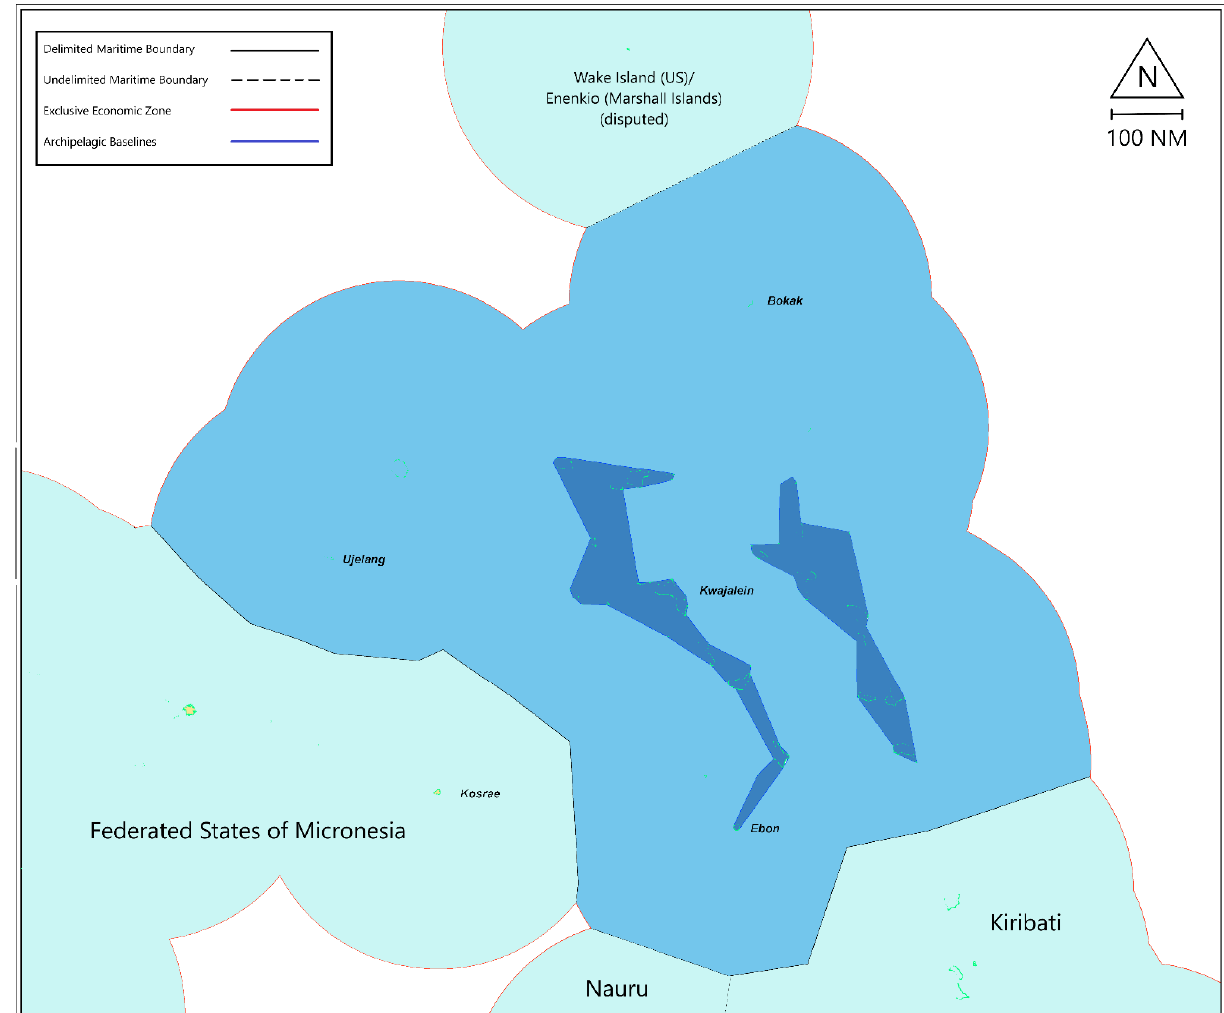
Figure 8. Location of Marshall Islands’s atolls and islands, including claimed EEZ areas and boundaries, as well as Enenkio/Wake Island.